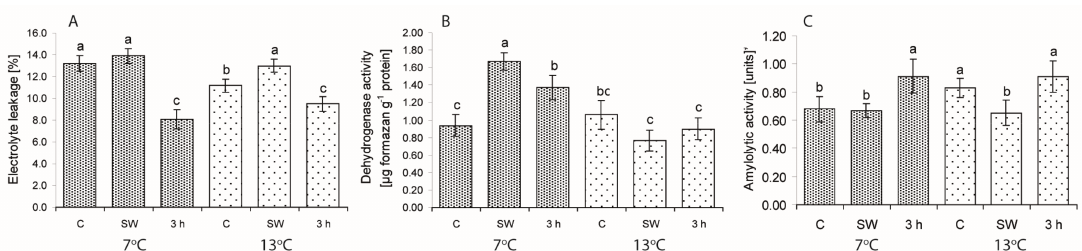
Figure 4. Effect of low (7 ◦ C) and control (13 ◦ C) temperatures and treatments on the percentage of ion leakage ( A ), dehydrogenase ( B ) and amylolytic activity ( C ) in the seeds of lines/cultivars included in Group II (well germinating). C—control, non-stimulated seeds; SW—smoke water; 3 h—3-h hydropriming. Values represent means ( ± SE) of four lines/cultivars based on five replicates in the case of DA and A, and on 10 replicates in the case of EL for each line/cultivar. Different superscript letters (a, b, c, ...) in the columns indicate significant differences between means (Duncan’s multiple range test; p < 0.05). One unit of amylolytic activity means a decrease in absorbance by 0.02, which released 0.1 mg of starch hydrolyzed in 10 min per 1 mg of